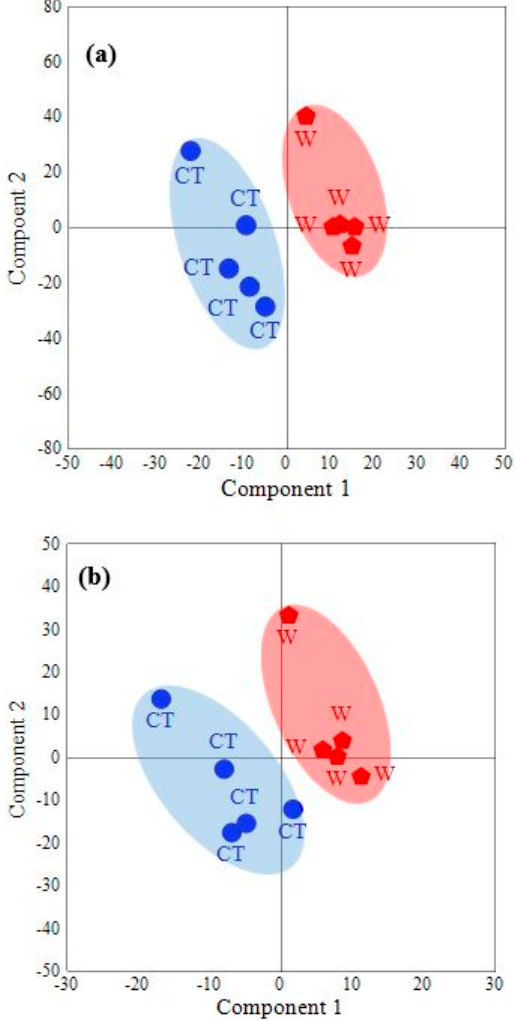
Figure 4. Partial least squares discriminant analysis (PLS-DA) score plots of the metabolites in Cunninghamia lanceolata under the control (CT) and warming (W) treatments ( n = 5 replicates each). Each data point represents one flag leaf sample of C. lanceolata, and the distance between points indicates the significant difference between samples. ( a ) ESI+ mode, ( b ) ESI − mode.